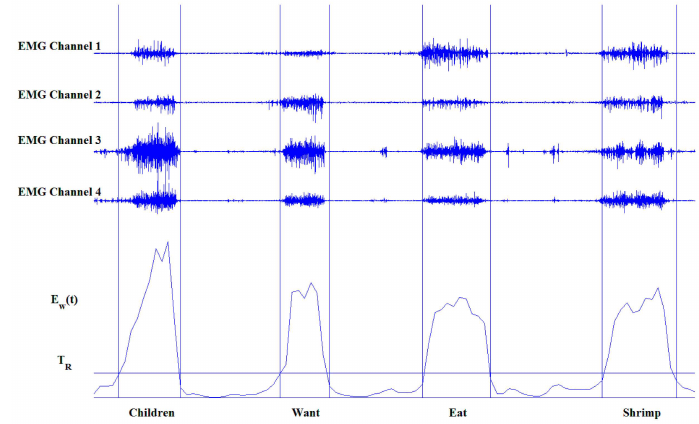
Figure 3. An example of the segmentation of a CSL sentence “Children want to eat shrimp,” which is constituted by four CSL subwords “children”, “want”, “eat”, “shrimp”.The predefined threshold T R is set as horizontal line. And the vertical lines indicate the subword